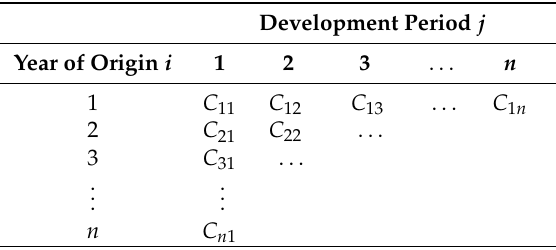
Table 1. Run-off triangle with incremental claim